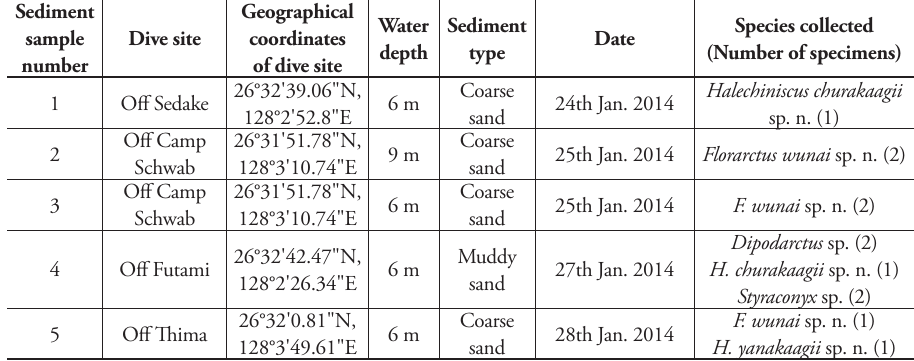
Table 1. Sediment samples collected from Oura Bay, Okinawajima, Ryukyu